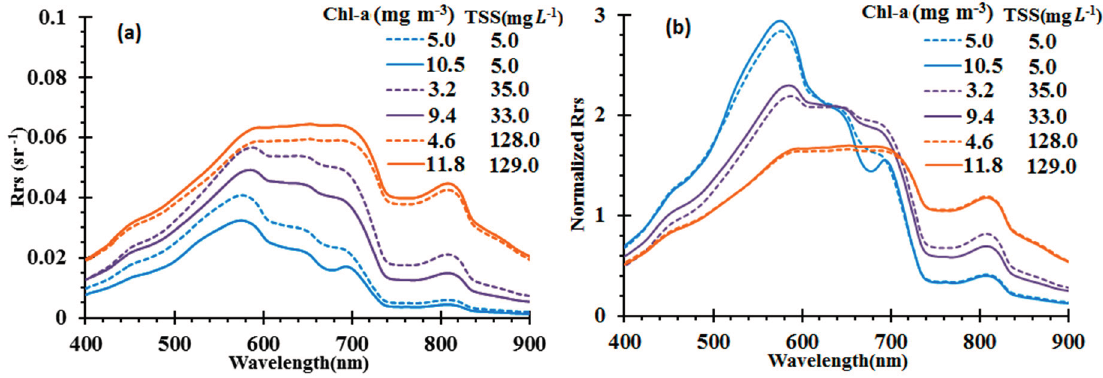
Figure 2. Typical raw ( a ) and normalized ( b ) R rs at different Chl-a and total suspended sediment (TSS) concentrations. While the raw R rs increase monotonously with TSS, the spectral difference between 500 and 700 nm could be observed in the normalized R rs when TSS is not extremely